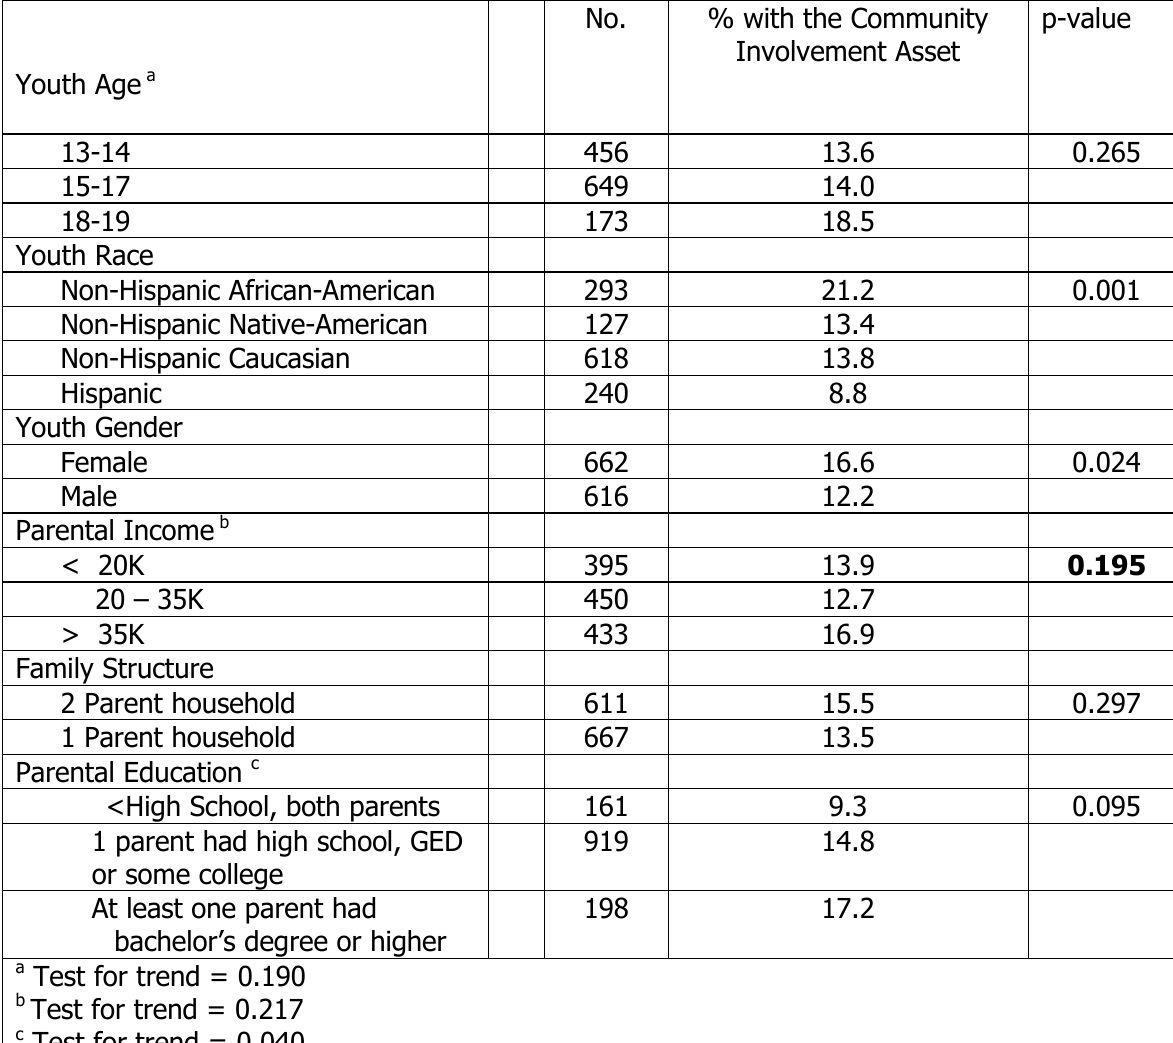
Frequencies and Chi-Square Values for Youth and Parent Demographics and Community Involvement Asset